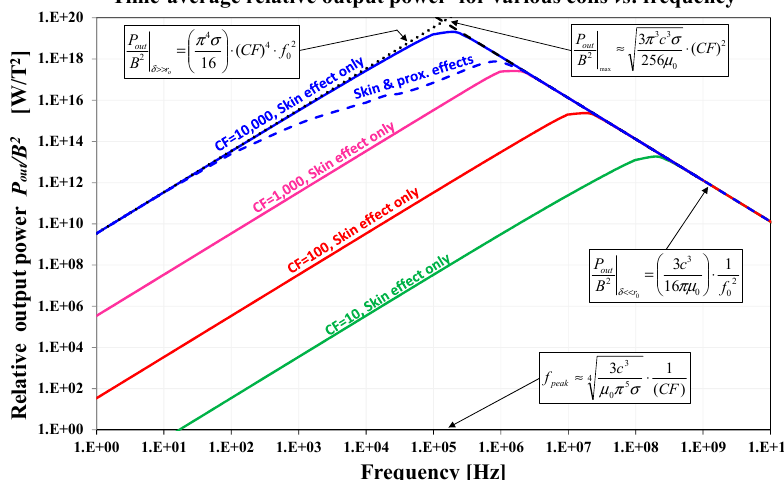
Figure 3. Time-average relative powers for four coils differ in size. For the largest coil ( CF =10,000 mm 1.25 ), also shown are the asymptotic lines that characterize the low-frequency and high-frequency behaviors along with the influence of ‘with proximity’ effect.